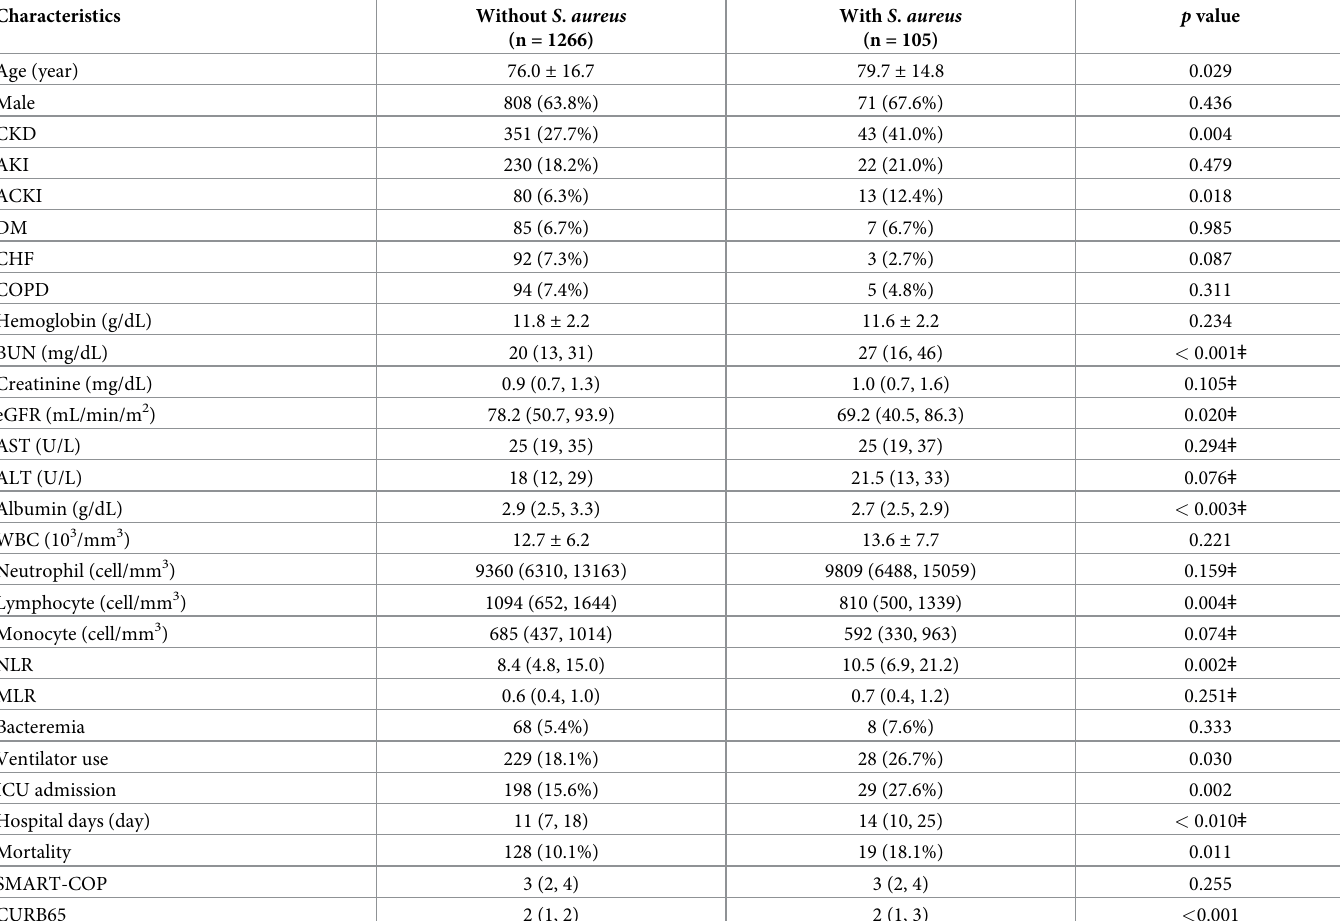
Table 4. Characteristics and outcomes associated with S . aureus in sputum.